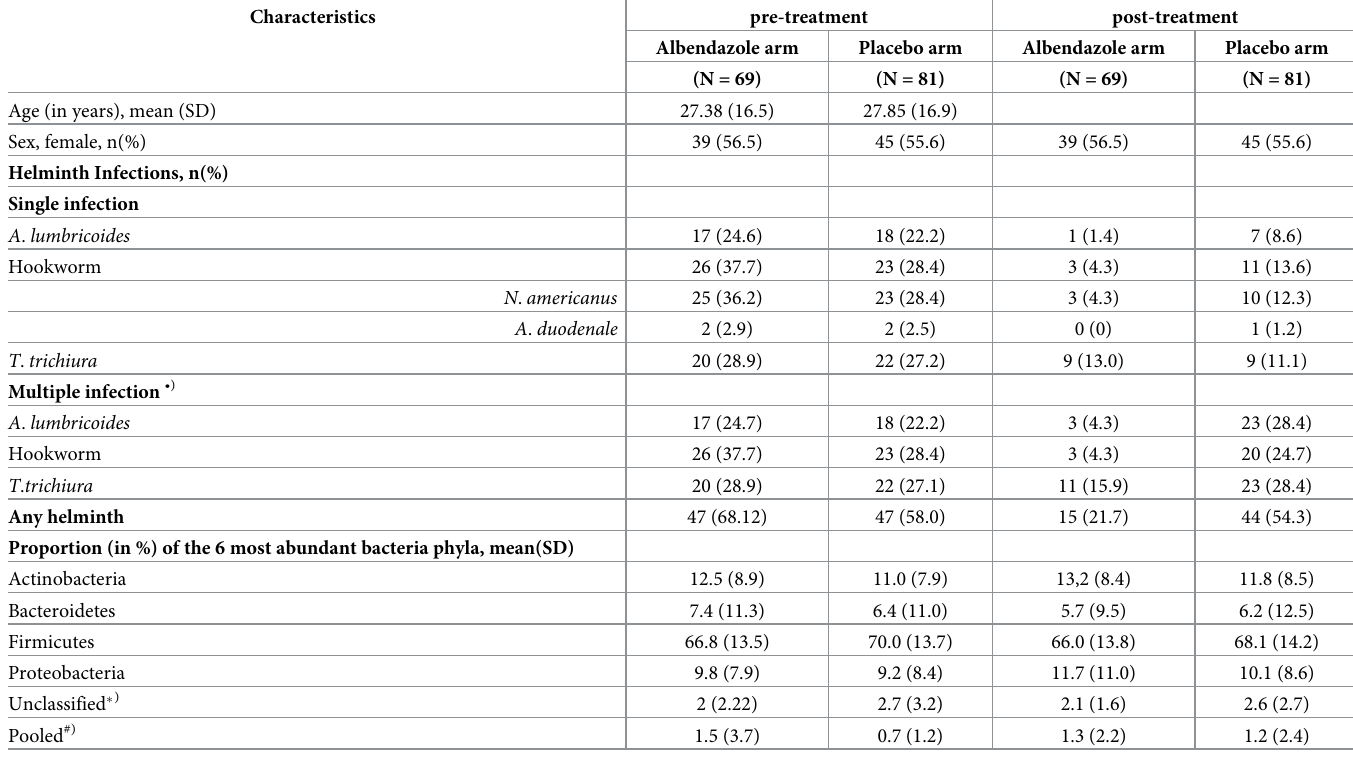
Table 1. Characteristics of the study subjects at baseline and at 21 months